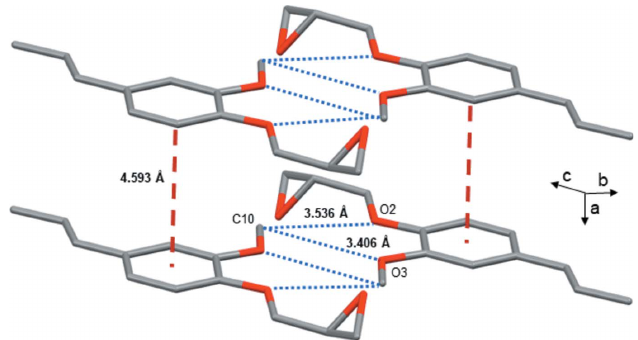
Figure 2 Mercury representation (Macrae et al. , 2020; colour code: C dark grey, O red; hydrogen atoms are omitted for clarity) showing intermolecular interactions in the crystal structure of the title compound with hydrogen bonding (blue dotted line, C—H (cid:3)(cid:3)(cid:3) O distance) and (cid:2) – (cid:2) stacking (red dotted line, centroid–centroid distance).